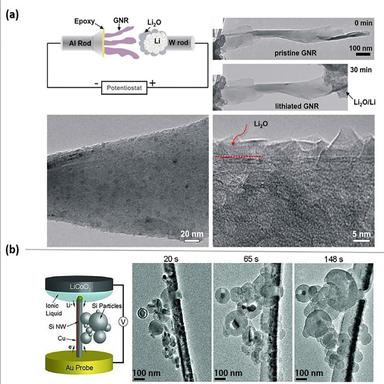
(a) Electrochemical lithiation of a GNR anode: Schematic illustration of in-situ experiment setup and TEM images (Reproduced with permission from ref. Copyright 2012 Elsevier); (b) in-situ TEM probing of lithiation process on silicon nanoparticles: The schematic diagram and operando TEM results at series of lithiation states (Reproduced with permission from ref. Copyright 2012 Wiley–VCH).